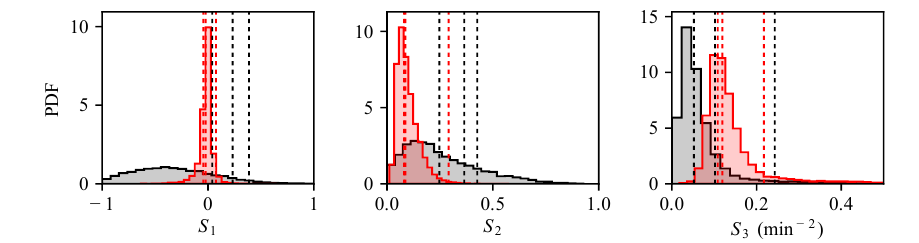
Figure 4. Probability density functions of S 1 – S 3 defined in Eq. (25) for RegA (black) and RegD (red) during 2015. The three selected historical hours are shown in the PDFs as vertical dashed lines.